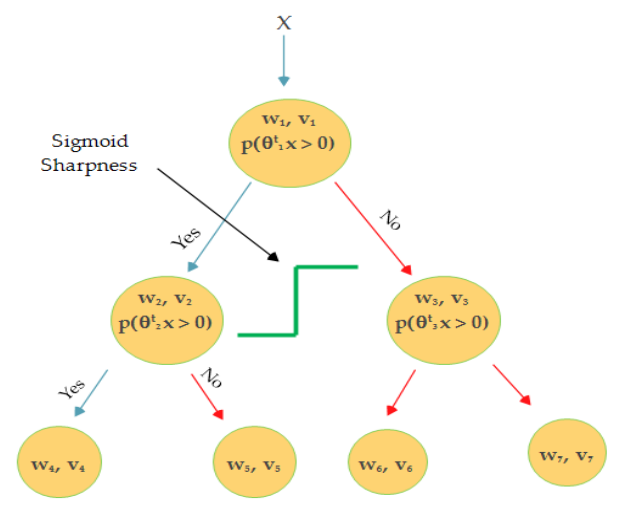
Figure 1. Schematic diagram of the as local deep support vector machine (LD-SVM).